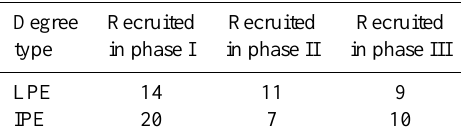
Table 3. Survey respondents per sub-group, based on their par- ticipation in local post-graduate education or international post- graduate education and their recruitment in one of the phases (phase I=1970–1987, phase II=1987–1998, and phase III=1998–